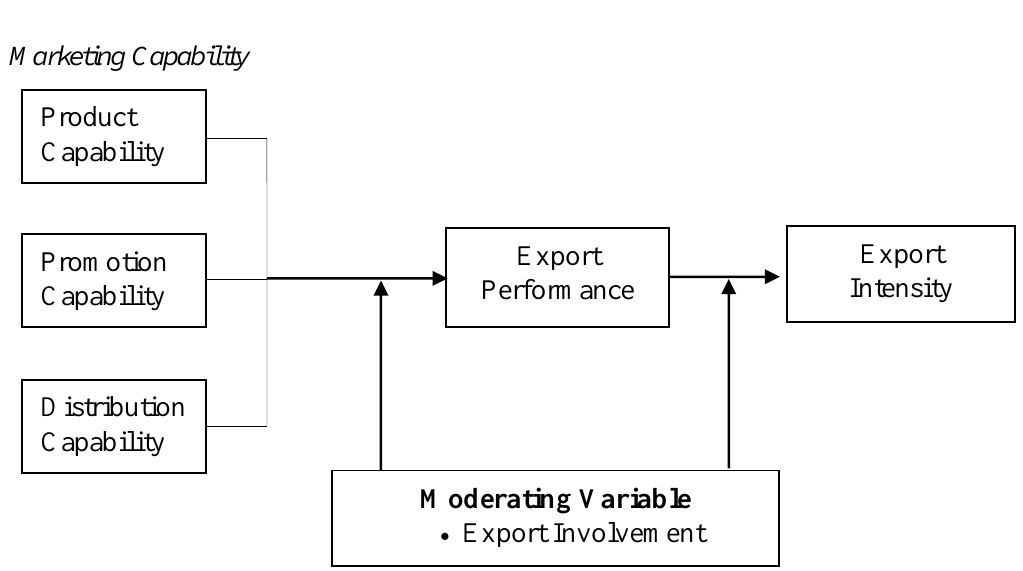
Figure 1: Conceptual